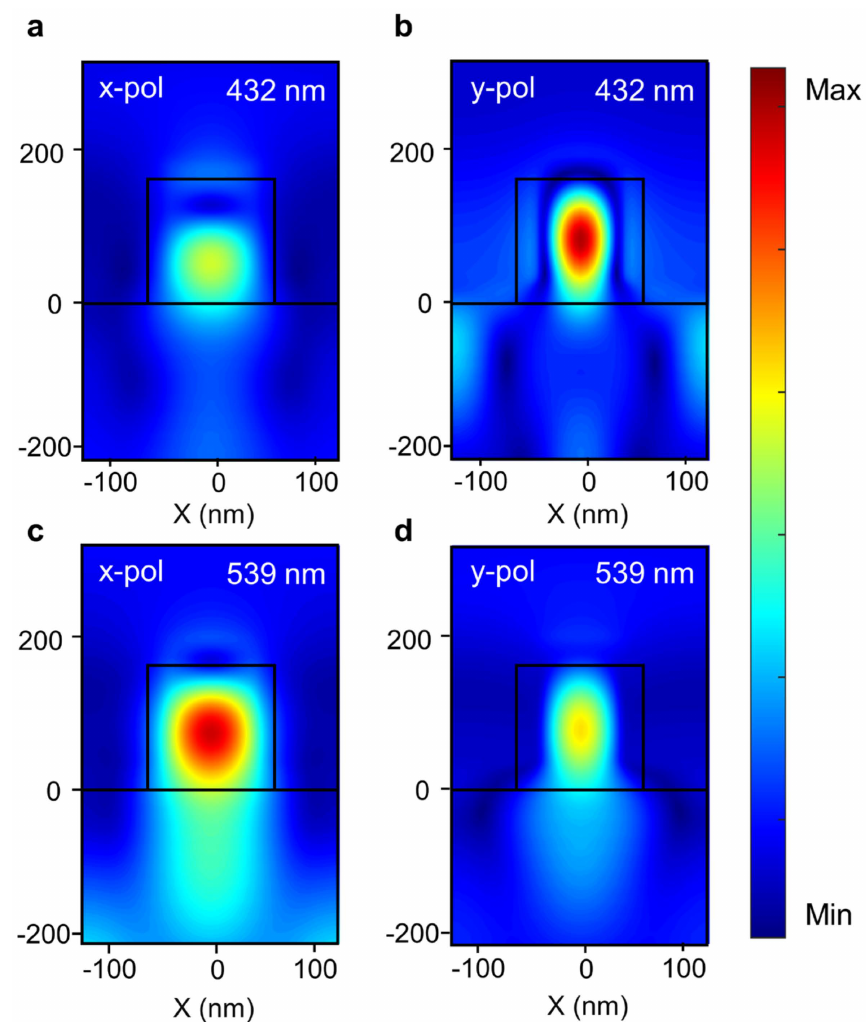
Figure 3. Simulated magnetic field distributions |H| in x–z plane at resonant wavelength of 432 nm under ( a ) x-polarization and ( b ) y-polarization, respectively, and at resonant wavelength of 539 nm under ( c ) x-polarization and ( d ) y-polarization,